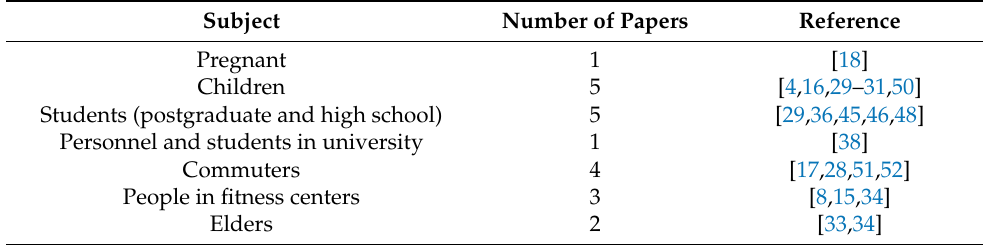
Table 4. Categories of subjects considered in this